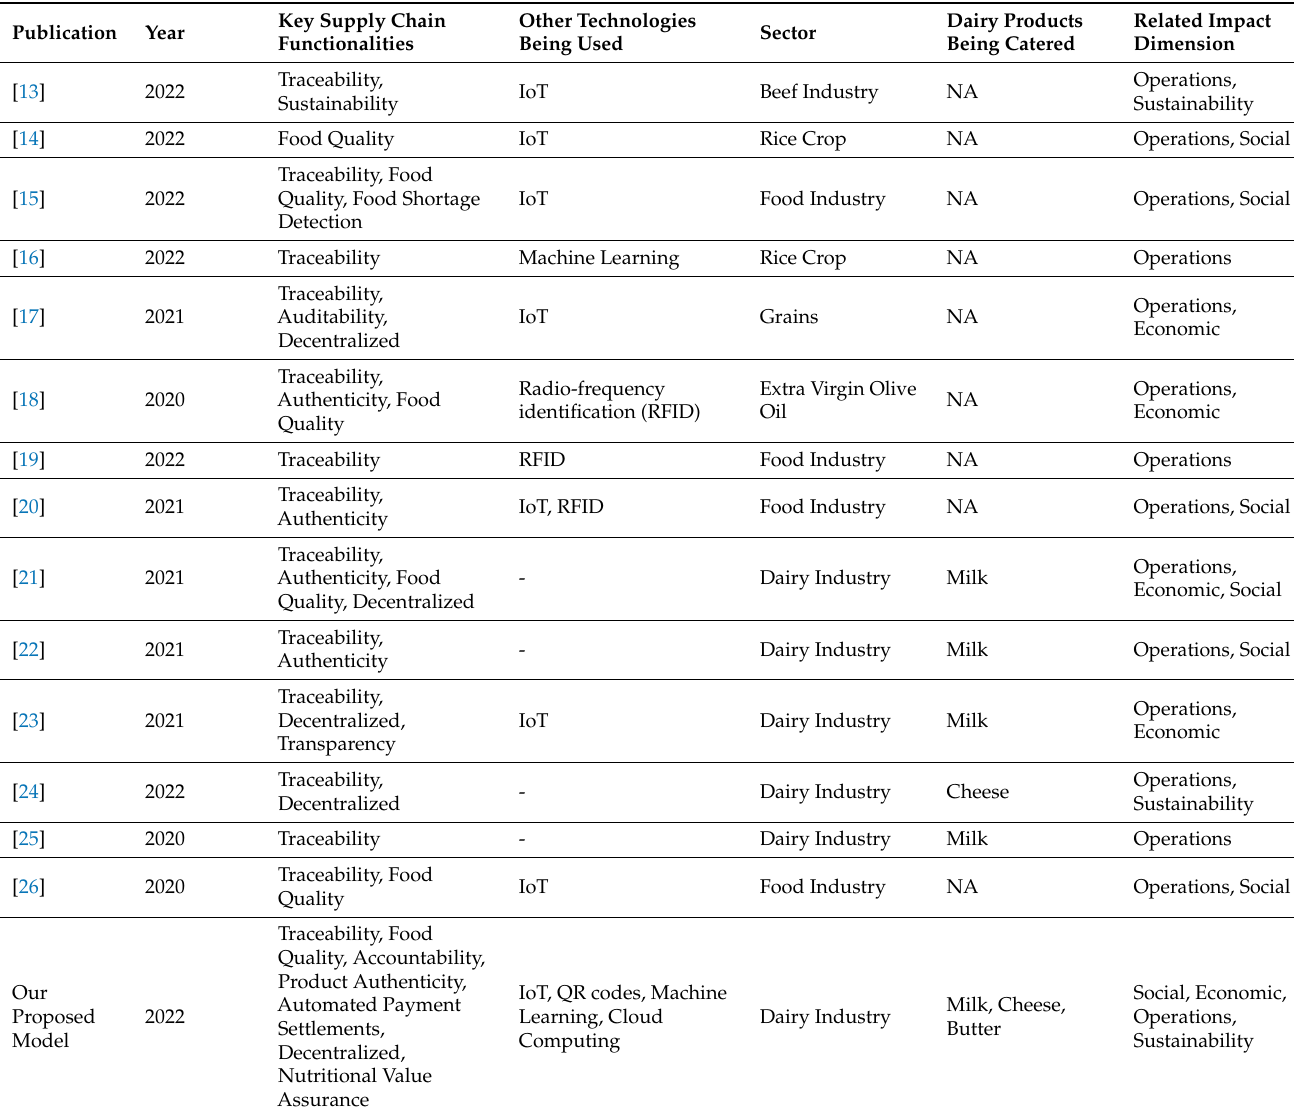
Table 1. Comparative analysis of recent works in food traceability and